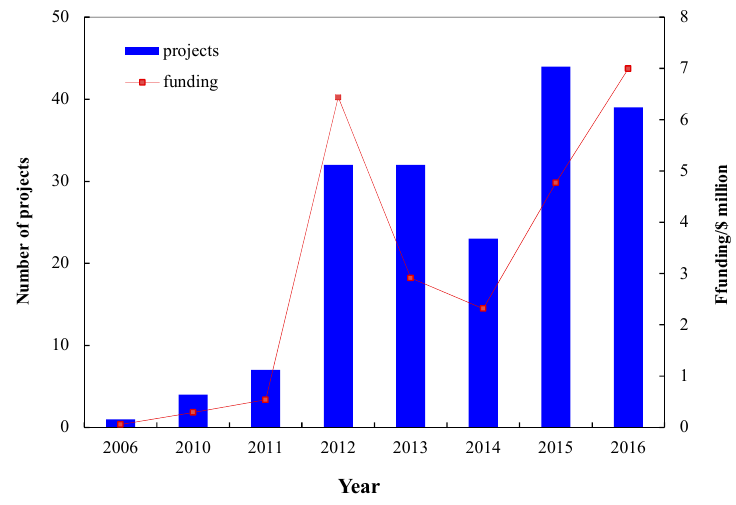
Figure 3. Shale gas-related research projects approved by NNSFC soared from 2010.